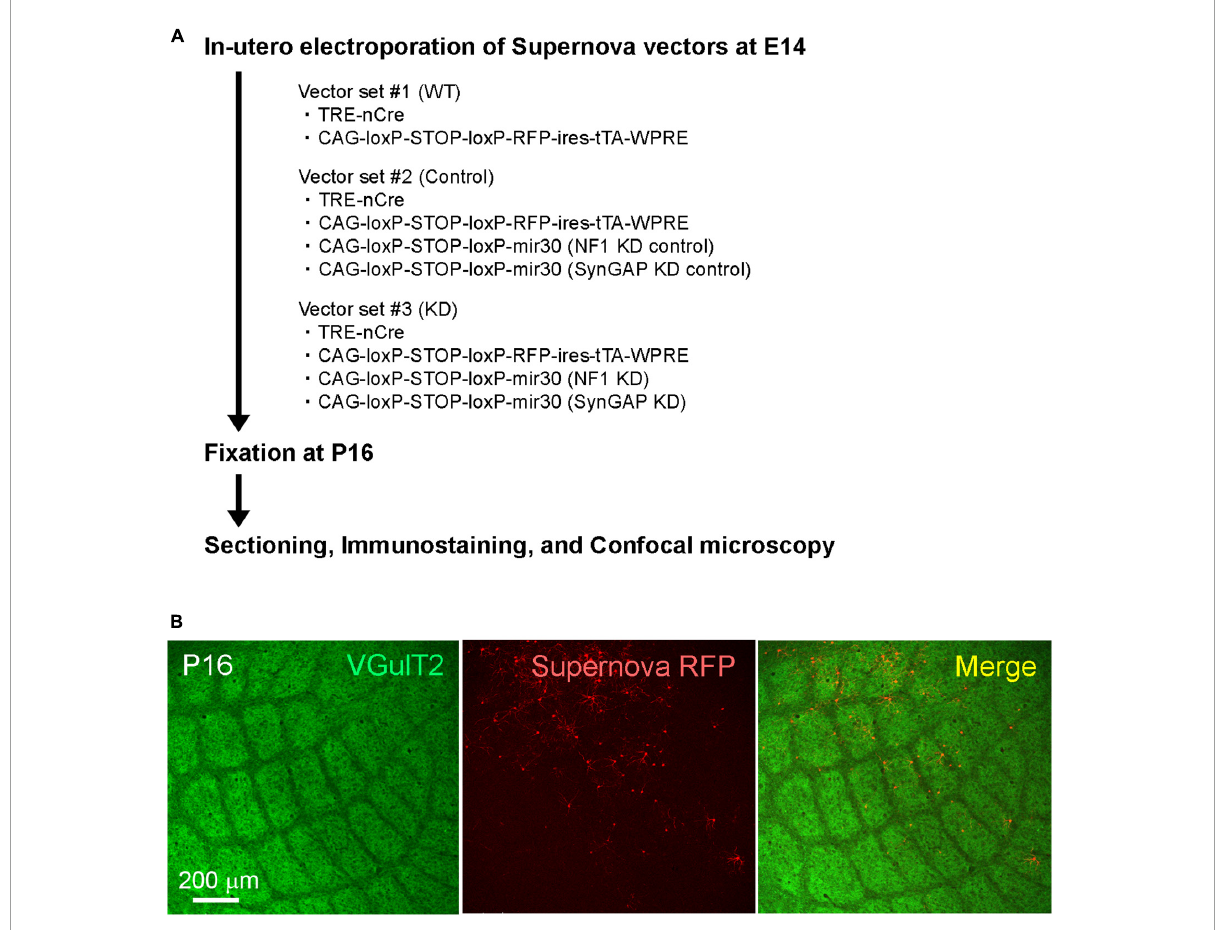
FIGURE1 (A) Schematic of the Ras GTPase-activating protein (RasGAP) knockdown experiments. (B) Example confocal images of VGluT2-immunostained tangential sections obtained from Supernova-electroporated P16